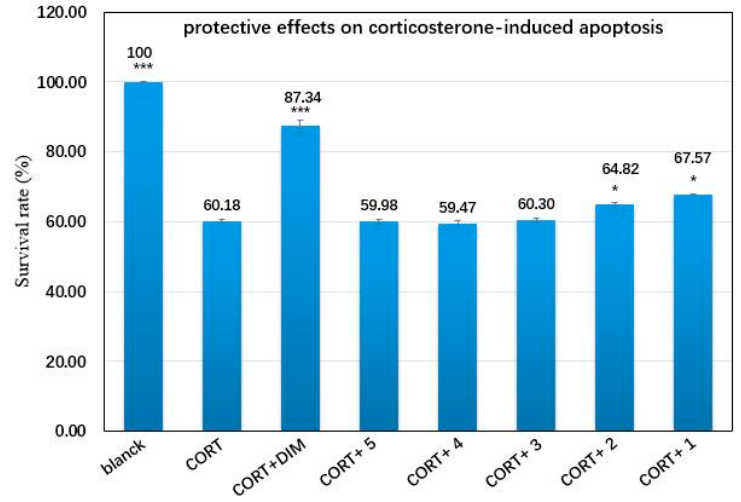
Figure 4. Protective effects of compounds 1 – 5 against corticosterone-induced apoptosis in PC12 cells. CORT = corticosterone, DIM = desipramine. Paired t-tests were used to evaluate the statistical significance of differences between different treatment groups and the model group (CORT). * Represents a p -value of < 0.05, *** represents a p -value of < 0.001.